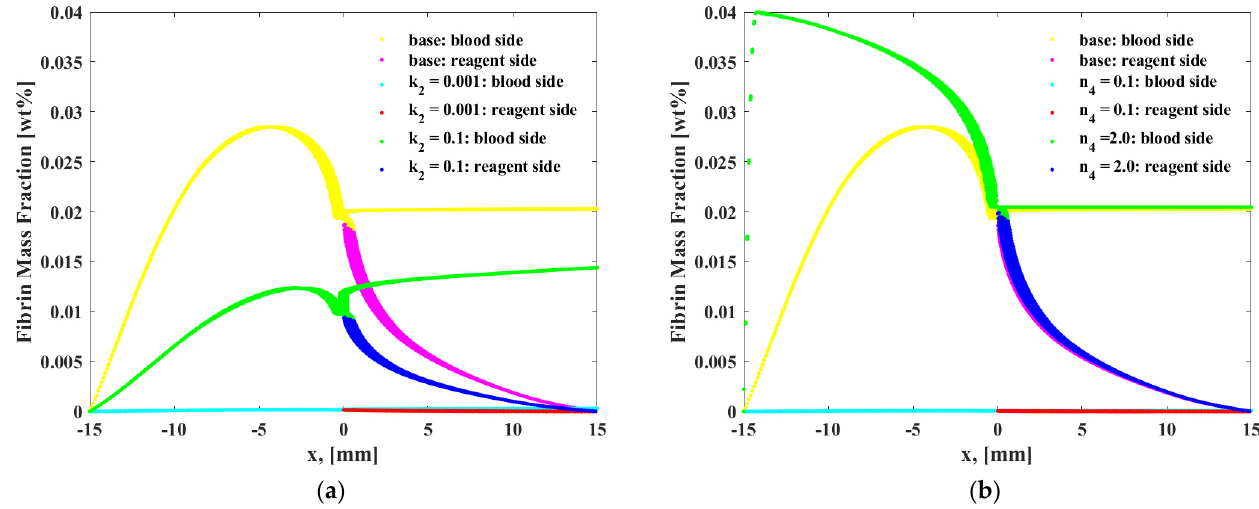
Figure 5. Distribution of the mass fraction of fibrin for ( a ) various k 2 and ( b ) n 4 . In this study, the parameters k 1 –k 3 obtained using the genetic algorithm were 0.987, 0.43, and 0.877, respectively, and those obtained for n 1 –n 5 were 0.548, 1.631, 1.23, 0.459, and 1.341, respectively. These results are indicative of the behavior of the prothrombin activator and fibrin in the microchannel. As can be seen in Figure 6, the chemical reaction with the anticoagulant does not occur at 1 s, because the prothrombin activator has yet to enter the mixed zone at this time. The prothrombin activator reacts with the anticoagu- lant within 3–5 s, and the reaction rate is high. Although a high prothrombin activator content is present in the blood at the side channel at 3 s, the activity of the prothrombin activator decreases after 5 s. Finally, the mass fraction of the prothrombin activator is nearly stable. ( a )